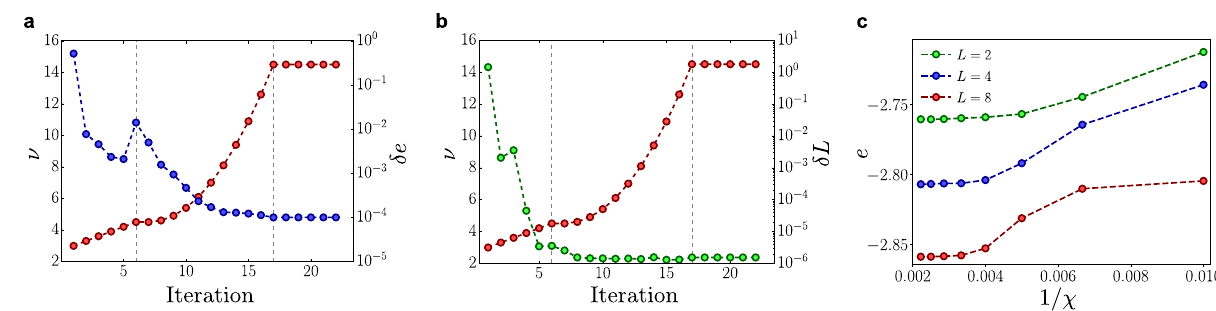
Fig. 8 Numerical convergence. a Driven optimization (in three steps: linear, quadratic, constant) of the penalty coef fi cient ν (red) and behavior of the energy (blue) as a function of the iterations for an exemplifying simulation. The energy is reported as the difference with the lowest fi nal energy that we reach. b Driven optimization of the penalty coef fi cient ν (red) and global error δ L (green) with respect to the link symmetry during the optimization steps. c Scaling of the energy density as a function of the inverse of the bond dimension 1/ χ . The bond dimension χ is in the range 100 ; 450